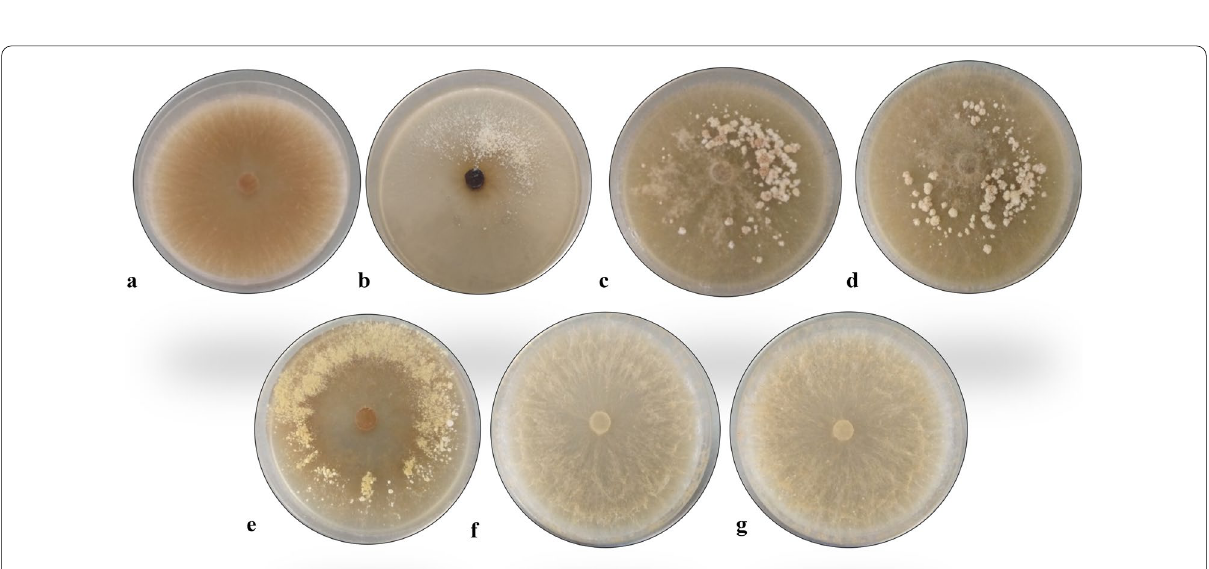
Fig. 3 Reference strain and wild morel isolates cultured in 90 mm Petri dishes of MEA‑coconut. All cultures were photographed fifteen days after inoculation. a M. esculenta CDBB‑H‑482, b isolate FRE‑3C, c isolate FRE‑5E , d isolate FRE‑6F, e isolate FRE‑I, f isolate FRE‑L, g isolate